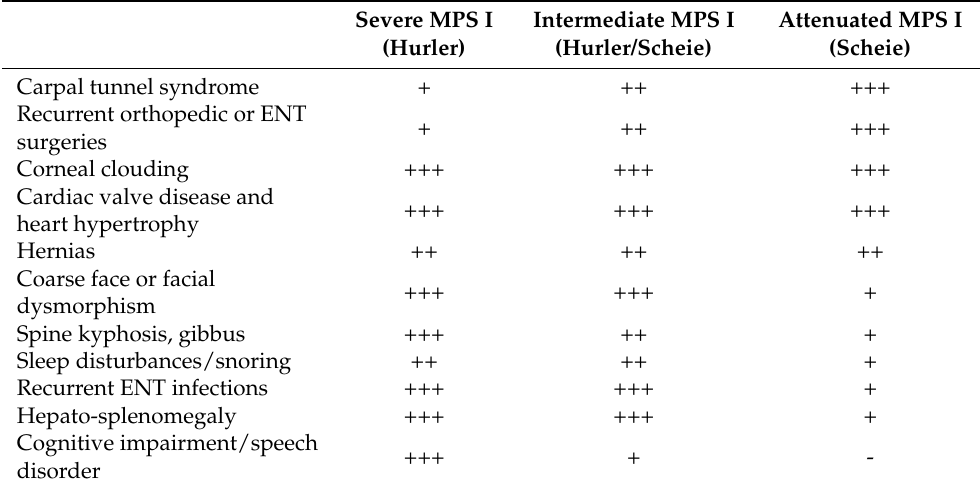
Table 1. Most common signs and symptoms of severe and attenuated MPS at diagnosis. Severe MPS